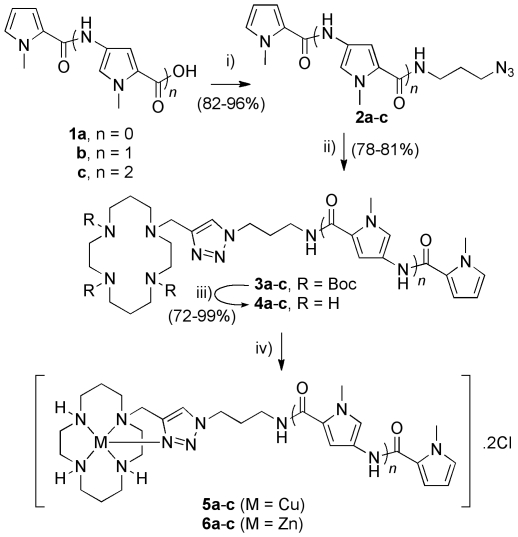
Scheme for reagents and conditions employed in ligand
synthesis.i) EDC·HCl, HOBt,
N,N-diisopropylethylamine,
3-azidopropylamine, dichloromethane, rt; ii) CuI (10 mol%),
sodium ascorbate (20 mol%), tBuOH/water (1∶1),
propargyl tri-boc protected cyclam, rt; (iii) TFA/dichloromethane
(1∶5), 6 h, rt, (iv) CuCl2 or ZnCl2 solution
in methanol, 5 min, rt.